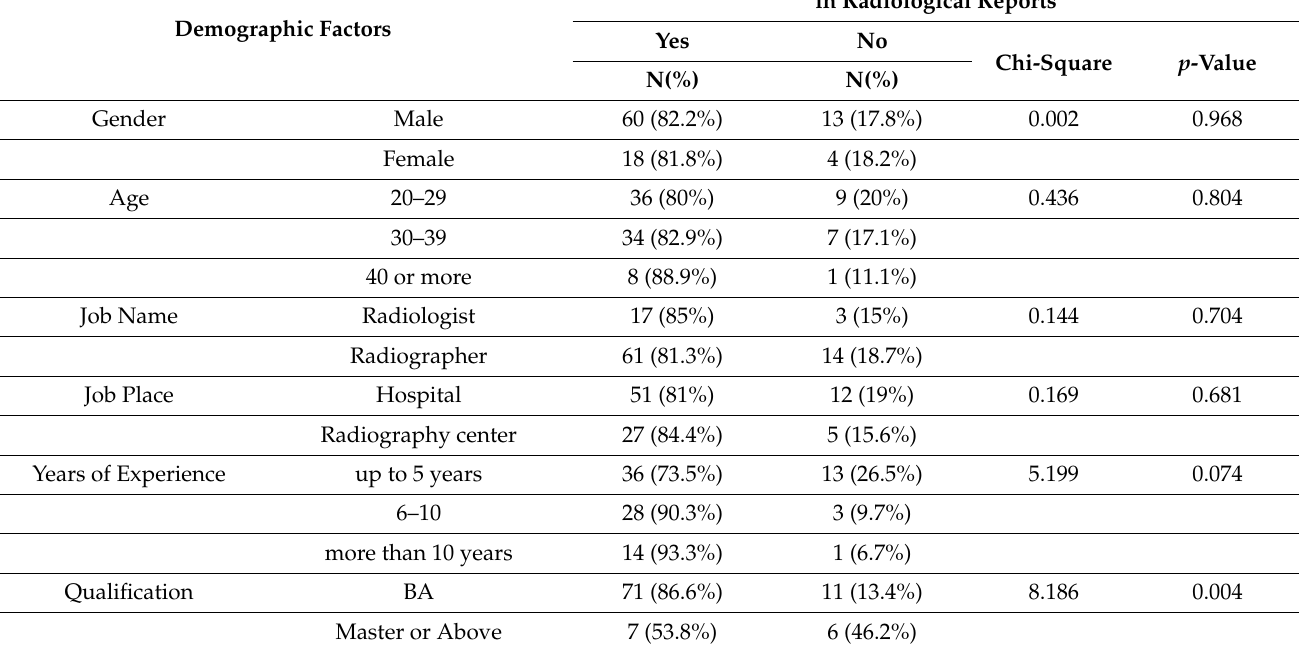
Table 5. The role of the radiologist in radiological reports. due to gender, age, job name, job place, years of experience, and